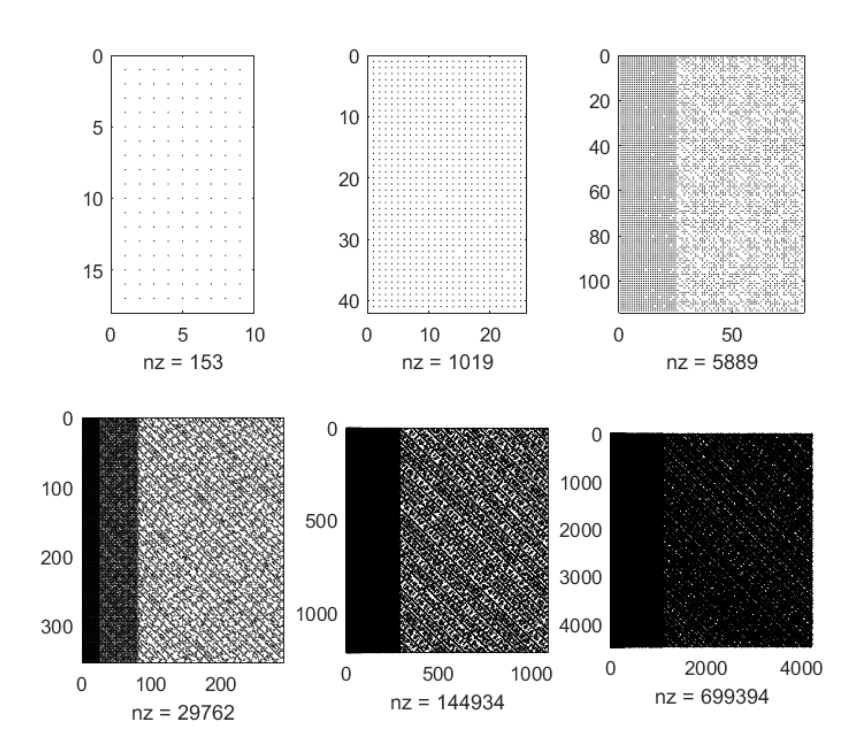
Figure 2. Sparsity behavior of H-RBF interpolation matrices at level 1, 2, 3, 4, 5, and